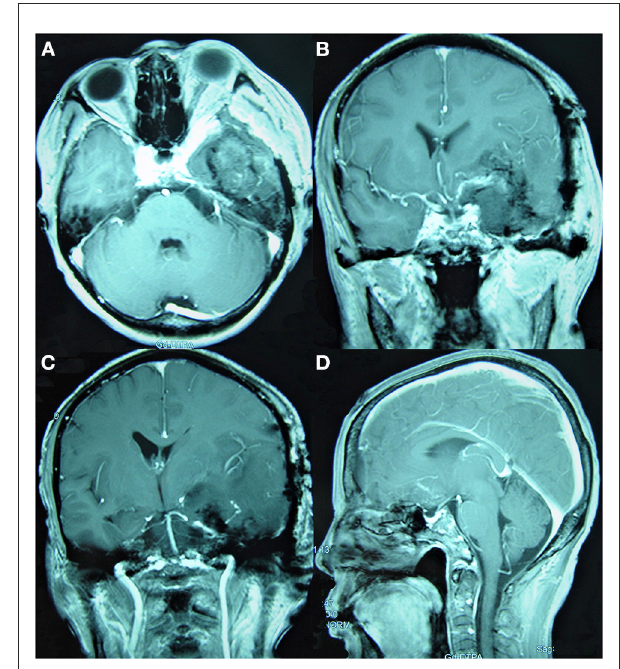
FIGURE3 Simpson Grade III total resection of a tumor as suggested by enhanced MRI reexamination on the second day after surgery. (A) The enhanced axial image. (B, C) The enhanced coronal images show that the tumor invading the cavernous sinus was mostly resected and that the middle and posterior cerebral arteries were well protected. (D) The enhanced sagittal image shows that the tumor in the anterior and central skull base was satisfactorily